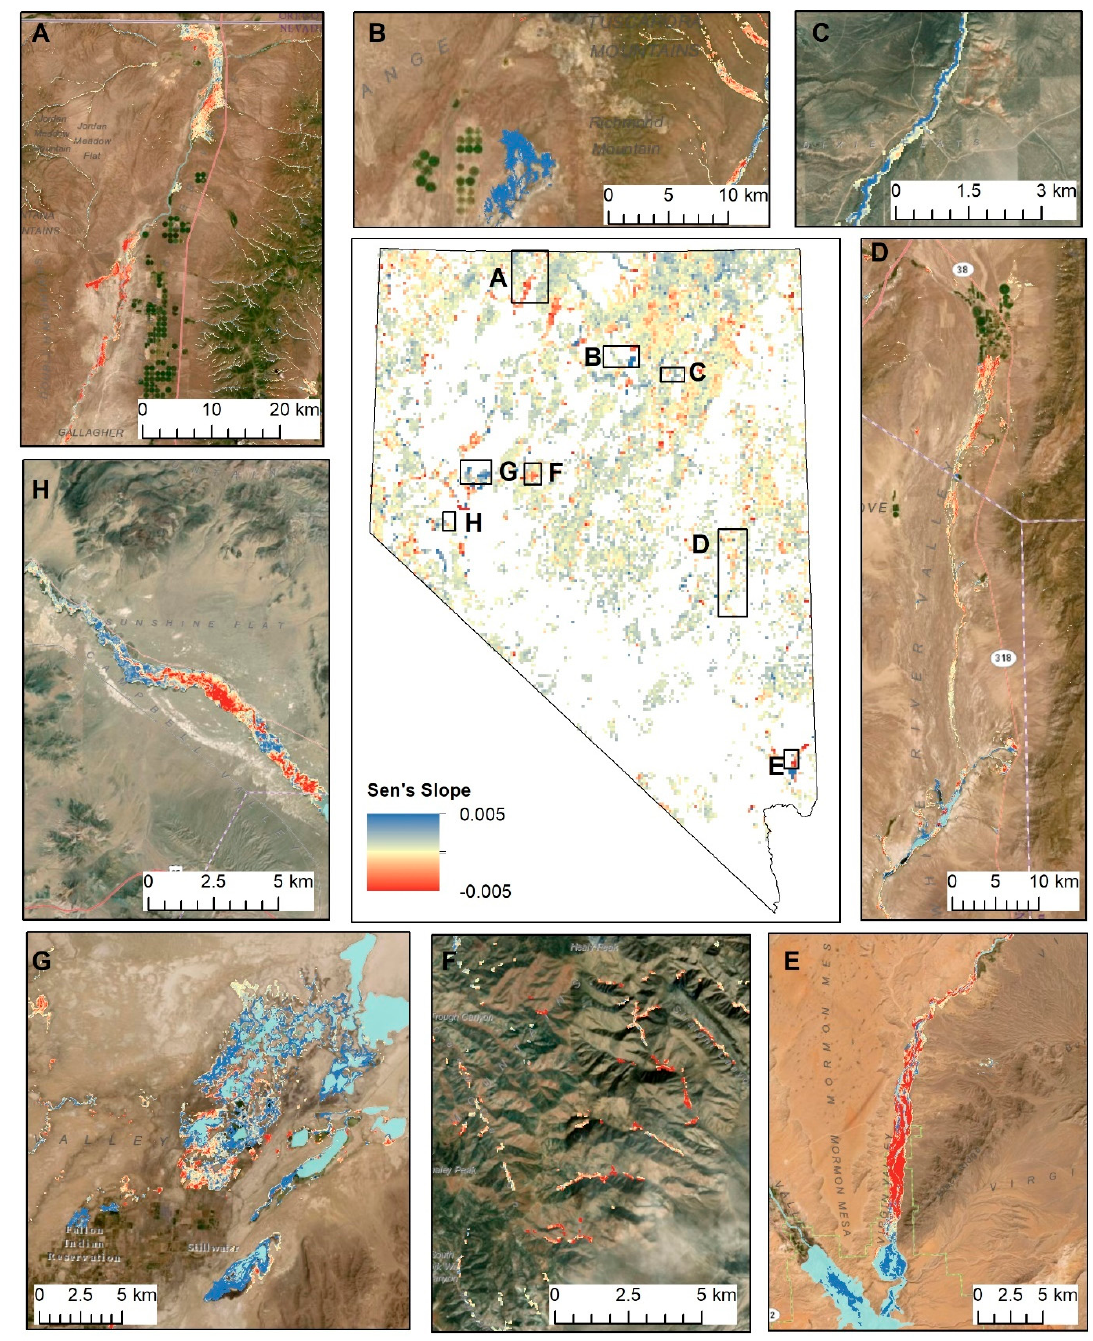
Figure 5. Statewide drought-adjusted trends in riparian areas (Figure 1), with 30 m resolution results aggregated 100x for visualization purposes (center) and at native resolution for select locations in the study area, including Quinn River Valley ( A ), Boulder Valley ( B ), Dixie Creek ( C ), the White River Valley ( D ), the Lower Virgin River Valley ( E ), the Clan Alpine Mountains ( F ), Stillwater National Wildlife Refuge ( G ), and the lower Walker River ( H ).